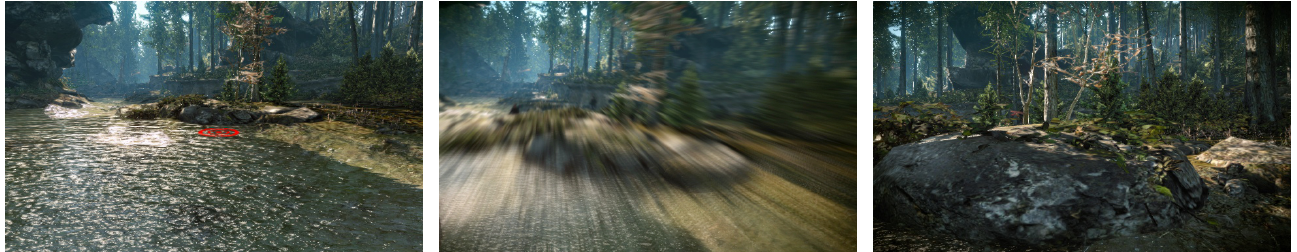
Fig. 3. Illustration of the jumper metaphor showing a jump sequence: (a) user’s view to a target location before the jump, (b) frame during the jump, and (c) after the jump at the target